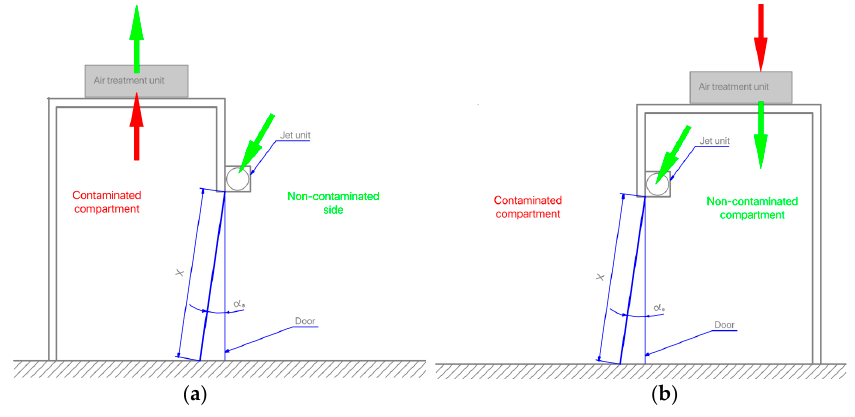
Figure 1. Strategies for the containment of a contaminant within a compartment ( a ) and for the protection of a clean room ( b ).